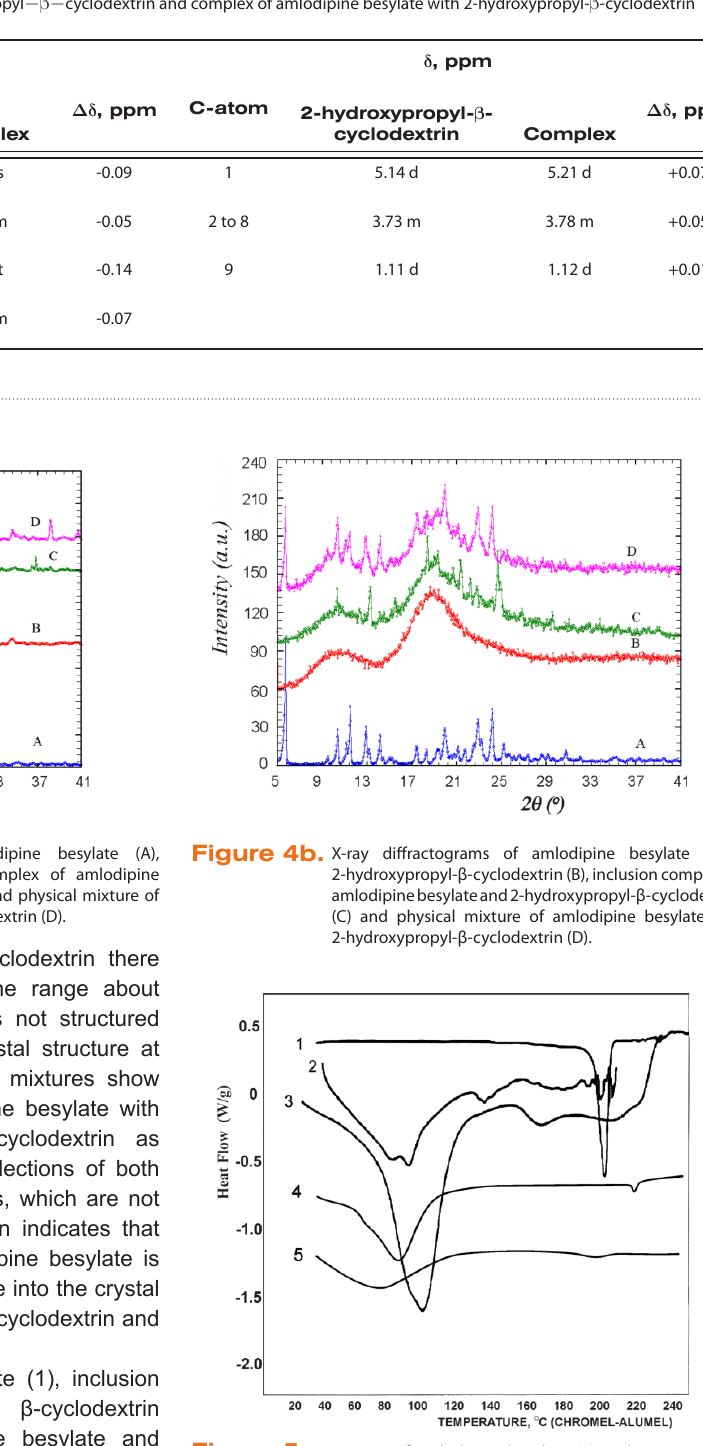
Figure 5. DSC curve of amlodipine besylate (1), inclusion complex of amlodipine besylate and β-cyclodextrin (3), inclusion complex of amlodipine besylate and 2-hydroxypropyl-β- cyclodextrin (2), β-cyclodextrin (4) and